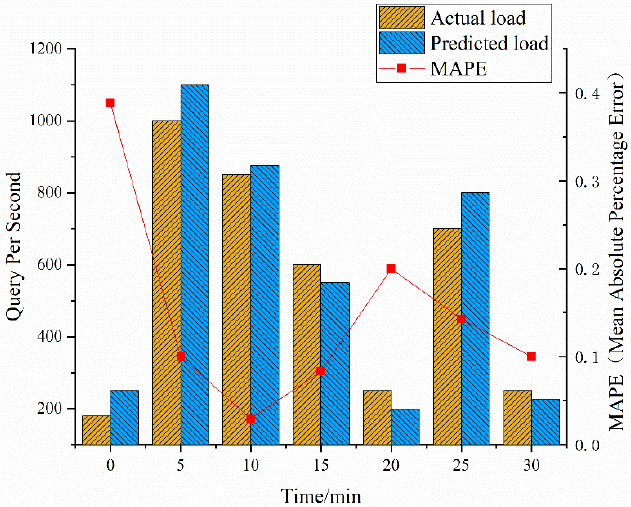
Figure 7. Test of the algorithm (drawn according to the test results after research and design combined with data).